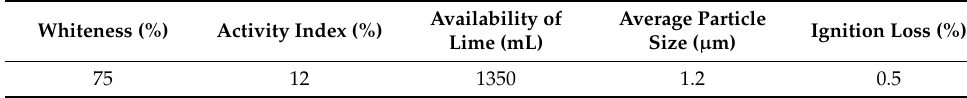
Table 2. The physical properties of MK.